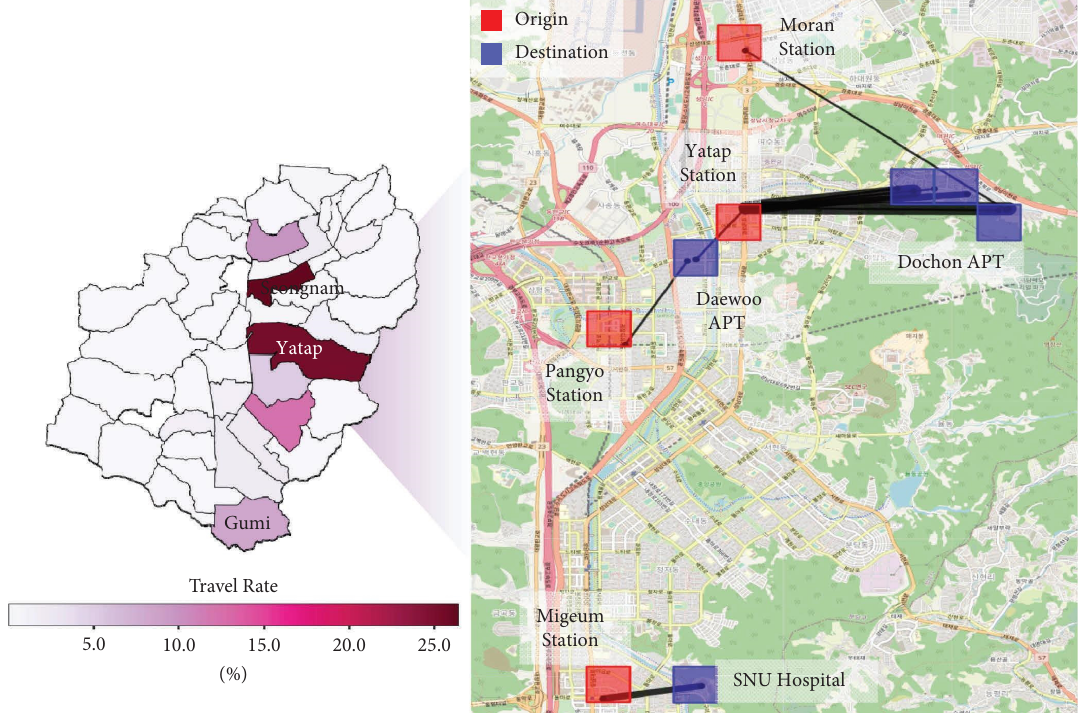
Figure 6: Top ten OD pairs of cluster